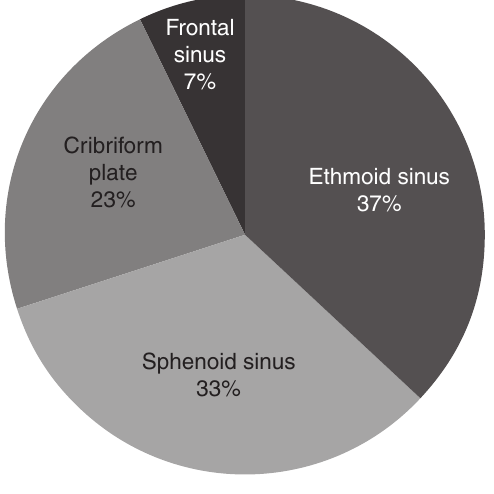
Figure 5 CSF leak fistula